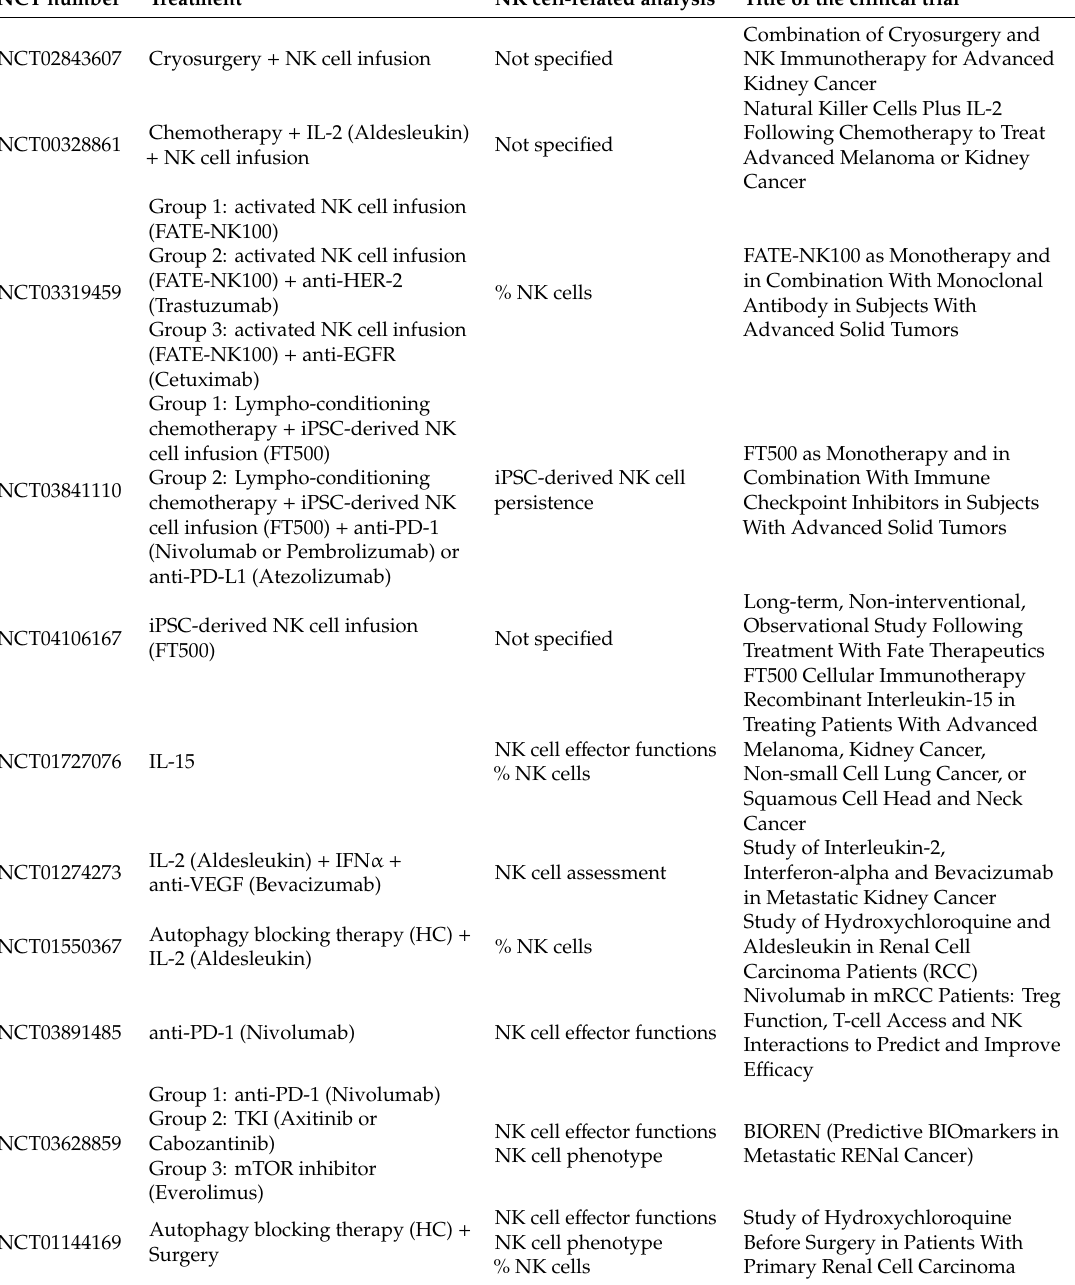
Table 1. Selected clinical trials on Renal Cell Carcinoma and NK cells